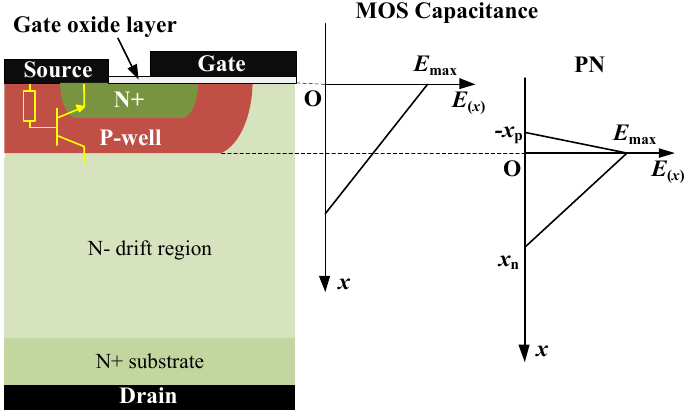
Figure 5. The internal electric field of SiC MOSFET.